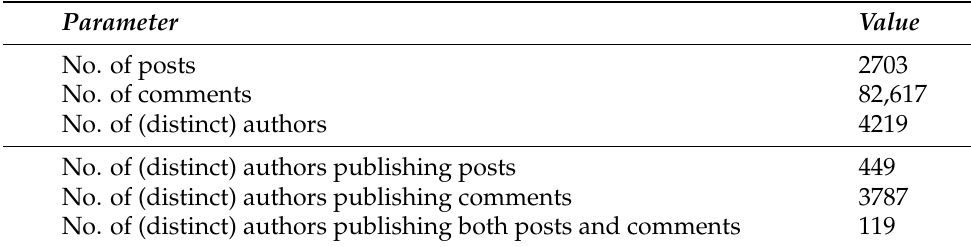
Table 1. Some main parameters of the dataset adopted for our